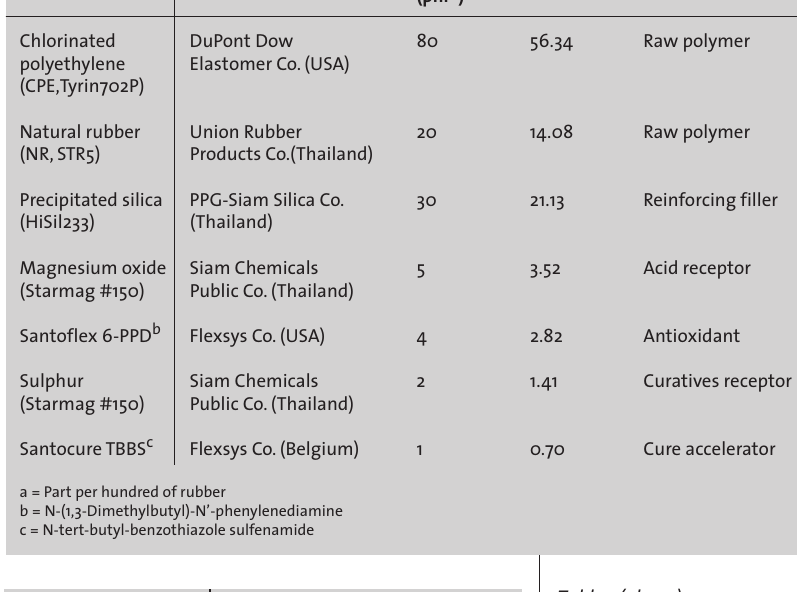
Table 1 (above): Materials used in the present study. Table 2: Mixing sequence used in the present